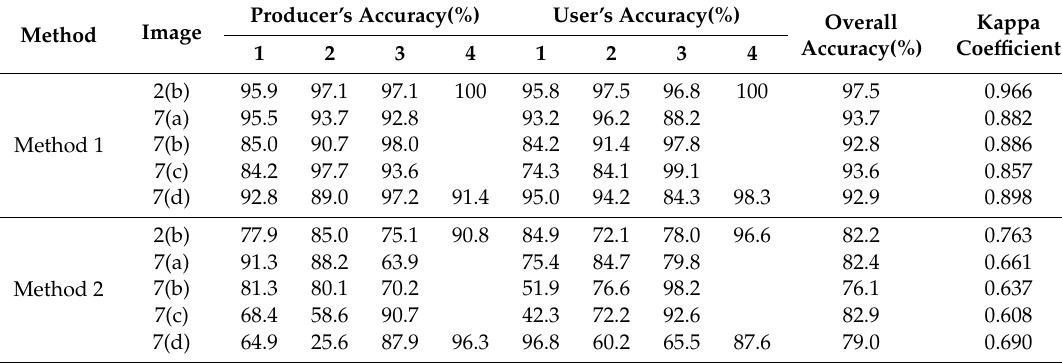
Table 6. Quantitative evaluation of the comparison of